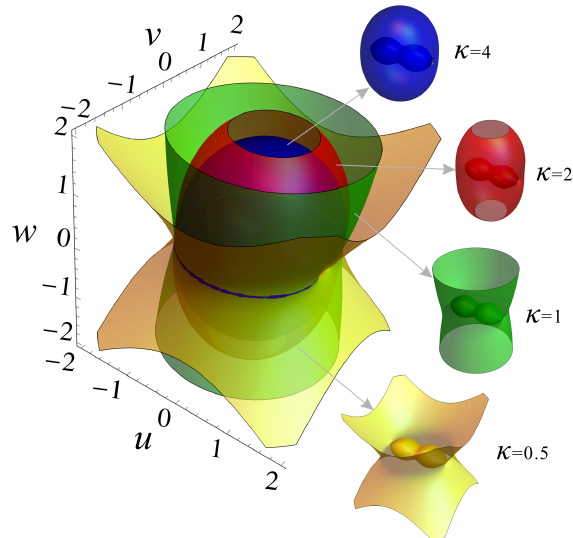
Figure 1. Zero velocity surfaces for κ = 0.5,1,2 and 4, respectively.